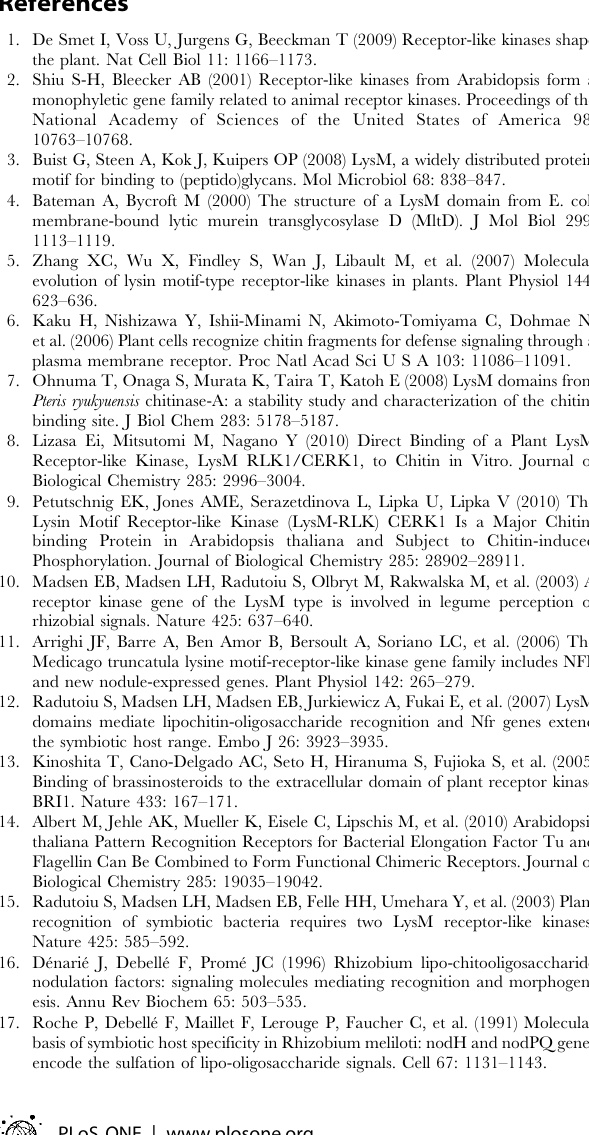
Figure S3 Complementation for pMtENOD11:GUS and nodulation of nfp plants by different chimeric constructs